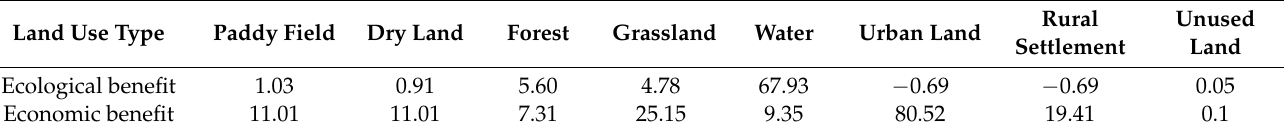
Table 2. Economic and ecological benefit coefficients per unit area in Fengdu County (unit: 10 4 CNY/hm 2 ). Land Use Type Paddy Field Dry Land Forest Grassland Water Urban Land Ecological